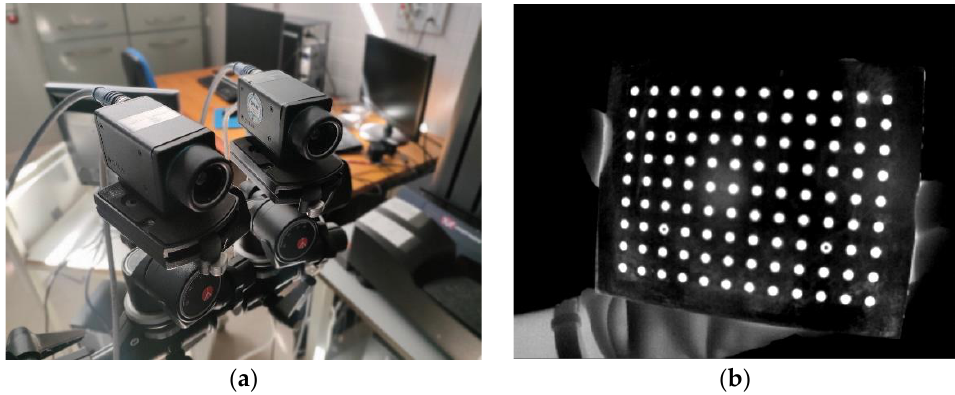
Figure 3 . ( a ) Camera set up for 3D-DIC. ( b ) Thermal image of calibration plates .